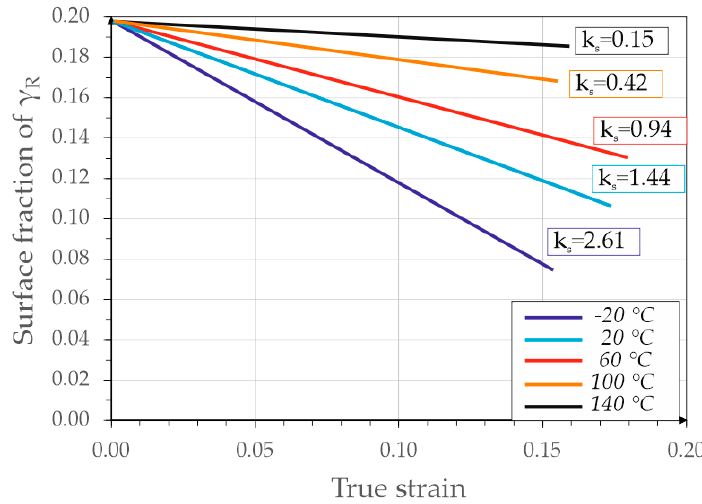
Figure 8. Logarithmic change of the surface fraction of retained austenite as a function of the true strain (at different deformation temperatures), showing the mechanical stability of this phase, expressed by the k s coefficient.